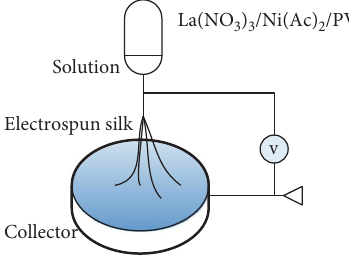
Figure 3: Electrospinning